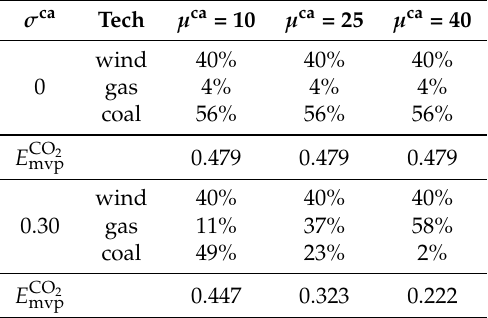
Figure 3. Systemic frontiers in the EEC mean-CVaRD plane ( − µ ∗ ,CVaRD ∗ ) under the two carbon volatility scenarios σ ca = 0 (left panel) and σ ca = 30% (right panel) for µ ca = 10, 25, 40. Table 4. Composition of minimum variance systemic portfolios. CO 2 emissions rates of such portfolios are also